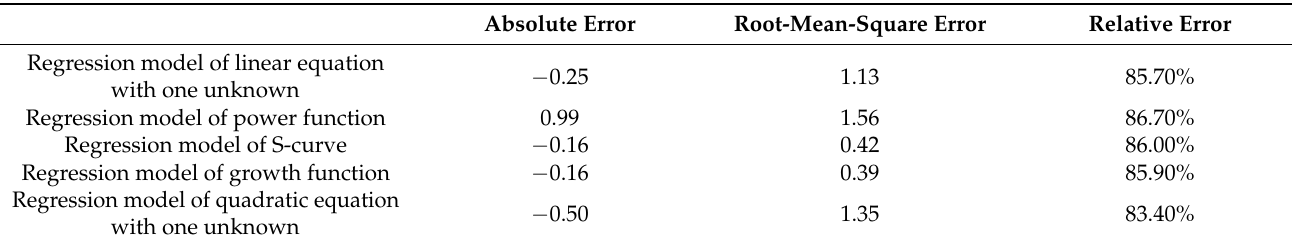
Table 6. The statistics of 3D-GSQ in the urban area of Hohhot. Absolute Error Root-Mean-Square Error Relative